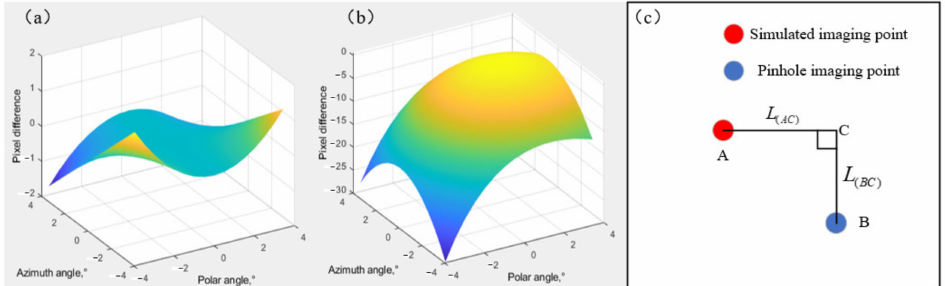
Figure 4. The difference between the imaging position of diffracted light at different incident angles of AOTF and pinhole imaging: ( a ) the difference in azimuth direction and ( b ) in polar direction, and ( c ) the image